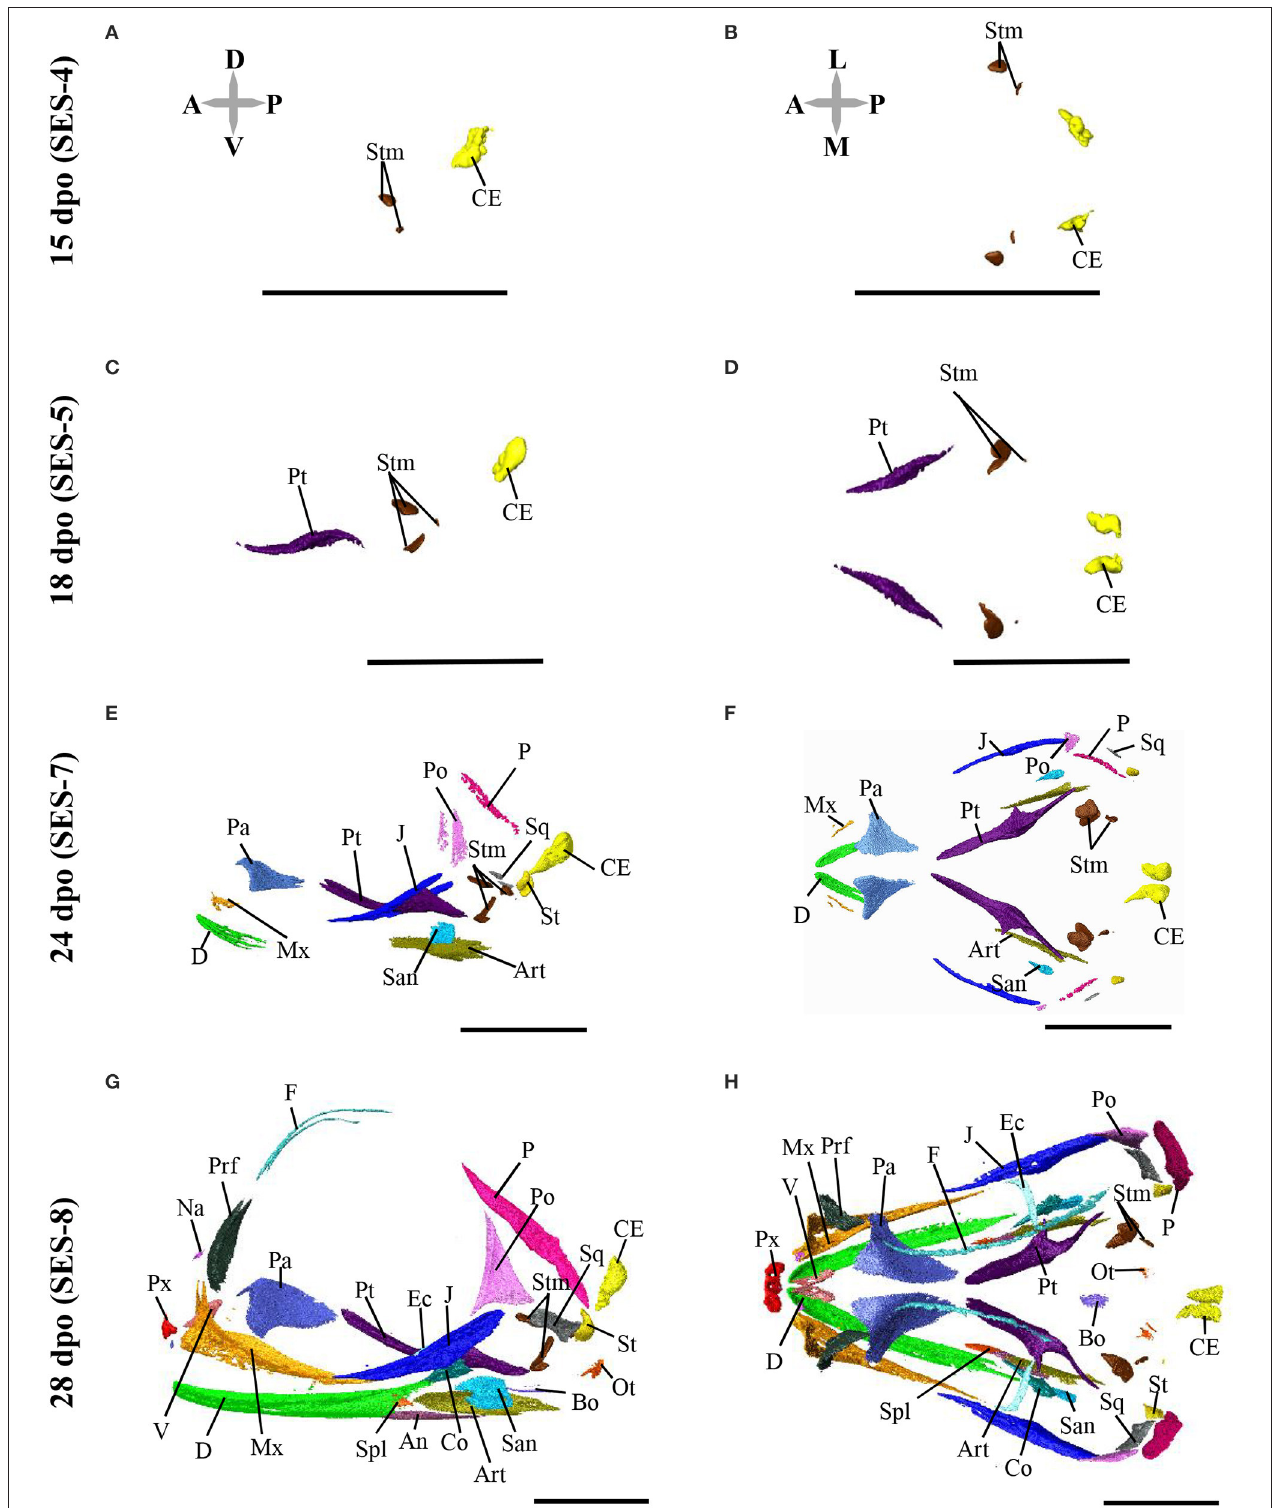
FIGURE 6 | Embryonic development of skull bones in Pogona vitticeps , part 1. Lateral (A,C,E,G) and dorsal (B,D,F,H) views of developing skull in Pogona vitticeps embryos at 15 dpo (A,B) , 18 dpo (C,D) , 24 dpo (E,F) , and 28 dpo (G,H) . Pictures are based on 3D isosurface renderings and segmentation of individual bones with different colors (see color-coding in Figure 3 ). Anatomical directions are indicated by gray double-headed arrows: D, Dorsal; P, Posterior; V, Ventral; A, Anterior; L, Lateral; M, Median. Scale bars = 2mm.